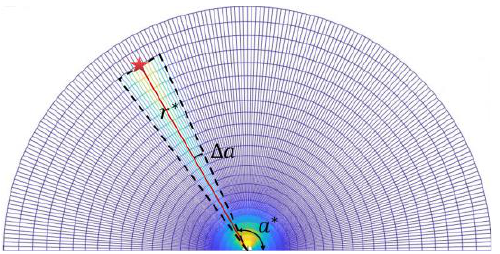
Figure 5. Probability distribution along the direction of the target point in a 180° fan search space.